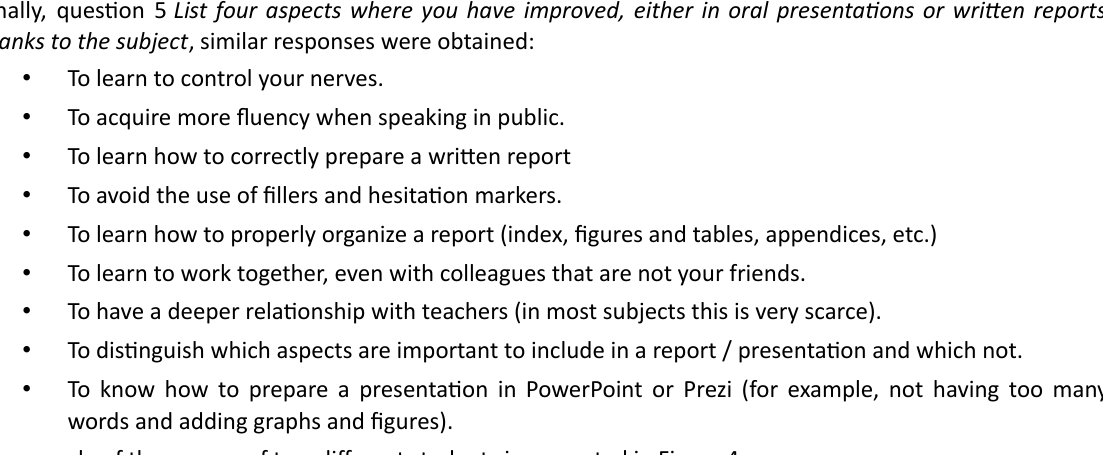
Figure 4. Students’ answers to the queston on issues where they detected an improvement